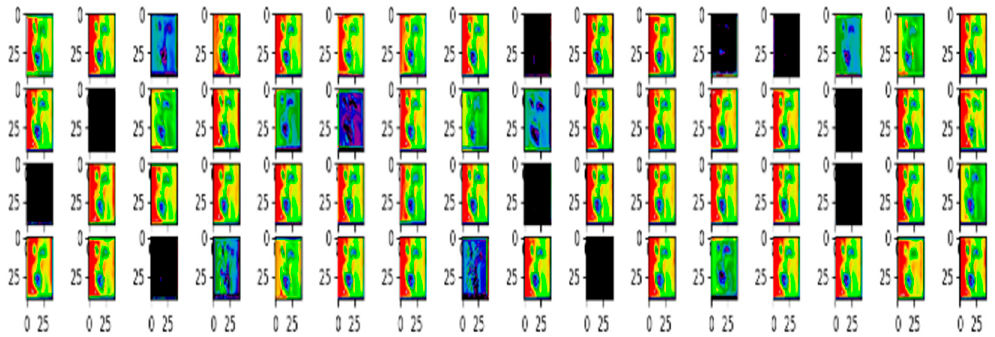
Figure 4. Visualization with ASFF module added.